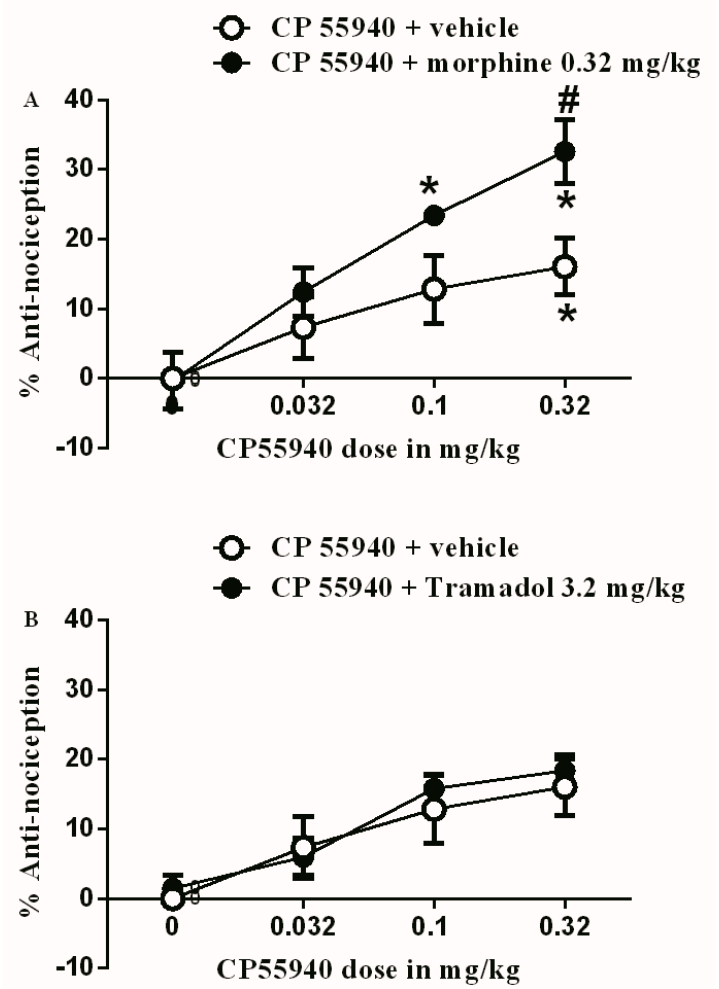
Figure 2. ( A ) Antinociceptive e ff ects of CP55940 (0.032, 0.1 and 0.32 mg / kg) either with vehicle or with sub-therapeutic dose of morphine (0.32 mg / kg) on CFA-induced mechanical allodynia. ( B ) Antinociceptive e ff ects of CP55940 (0.032, 0.1, and 0.32 mg / kg) either with vehicle or with sub-therapeutic dose of tramadol (3.2 mg / kg) on CFA-induced mechanical allodynia. Data are presented as the mean ± SEM of %antinociception. %antinociception = (PWT Post-drug – PWT Pre-drug) / (baseline PWT – PWT pre-drug). Data were analyzed using two-way ANOVA followed by the Holm–Sidak post hoc test, # indicates a significant di ff erence between rat groups. * indicates a significant di ff erence in comparison with day 0 within each rat group.